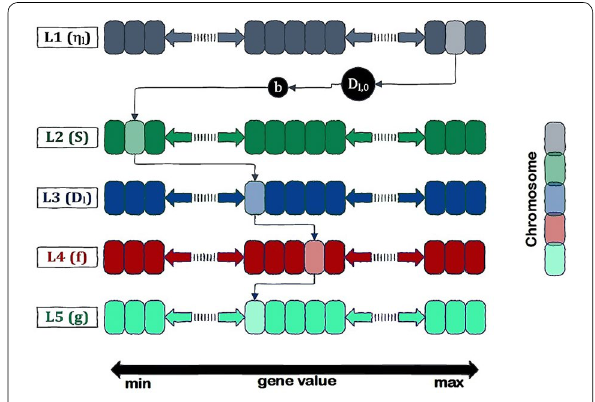
Fig. 1 GTHA Layers, with a sample selected chromosome comprising five genes (in faded